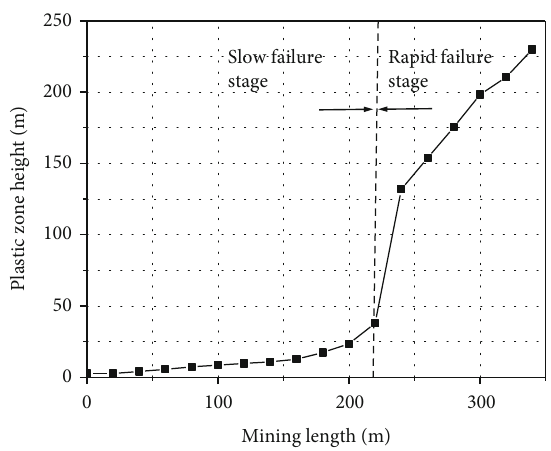
Figure 9: The maximum height change of the plastic